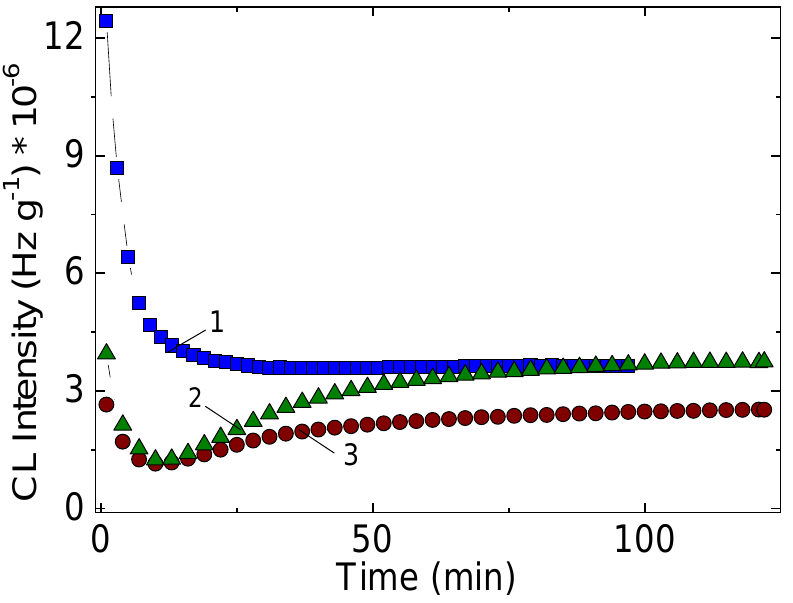
Figure 3. Isothermal CL spectra recorded on the samples consisting of SIS and PCL components subjected to an irradiation γ -dose of 100 kGy: (1) SIS:PCL = 3:1, (2) SIS:PCL = 1:1, (3) SIS:PCL = 1:3. Testing temperature : 140 °C.